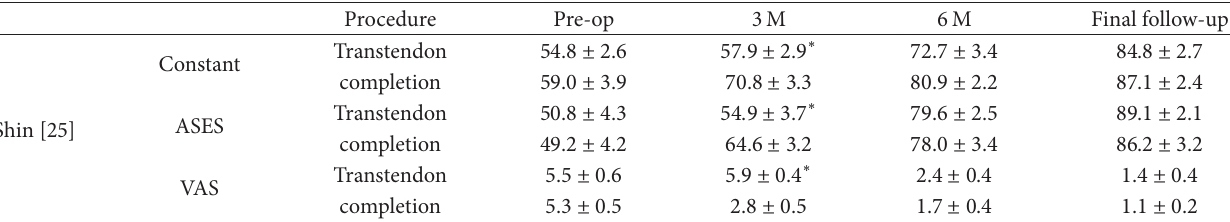
Table 5: Short-term recovery.